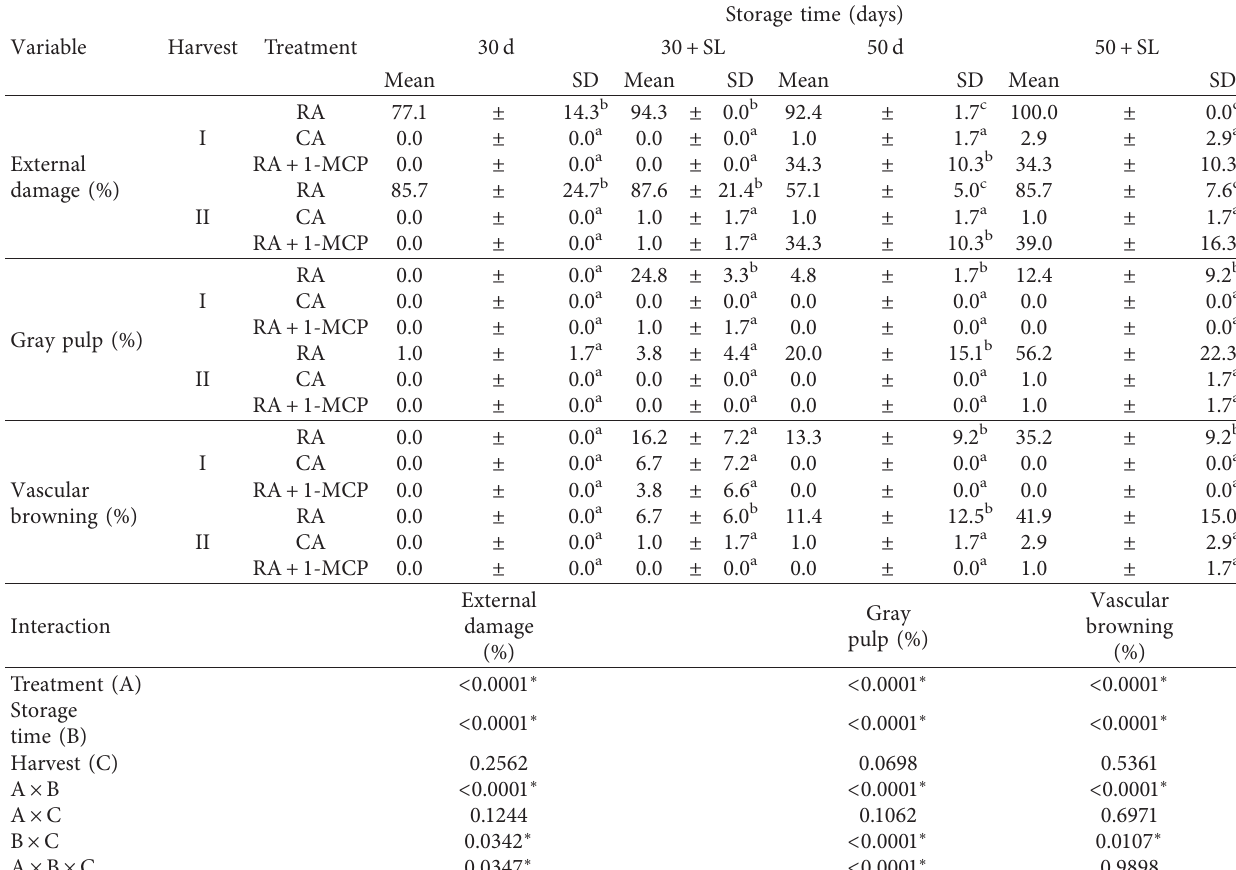
Table 9: Evaluation of physiological disorders in “Edranol” avocado under different storage conditions for 30 and 50 days at 5 ° C. Variable